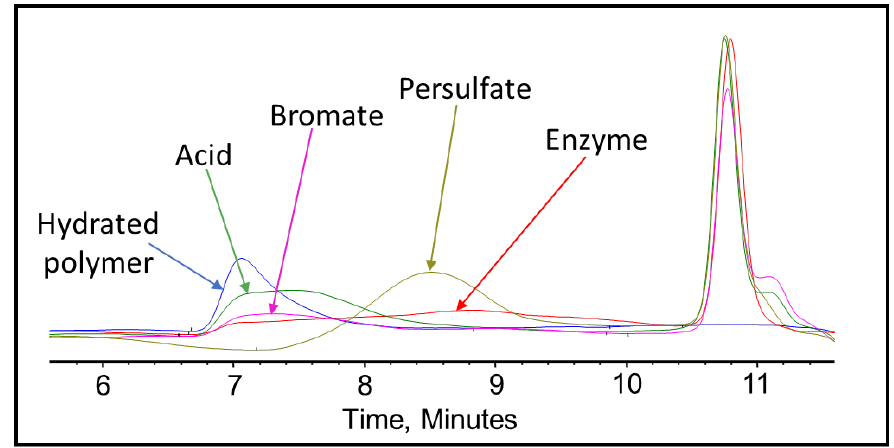
Figure 8. GPC results of the 45 lb/1000 gal crosslinked fracturing fluid exposed to different gel breakers